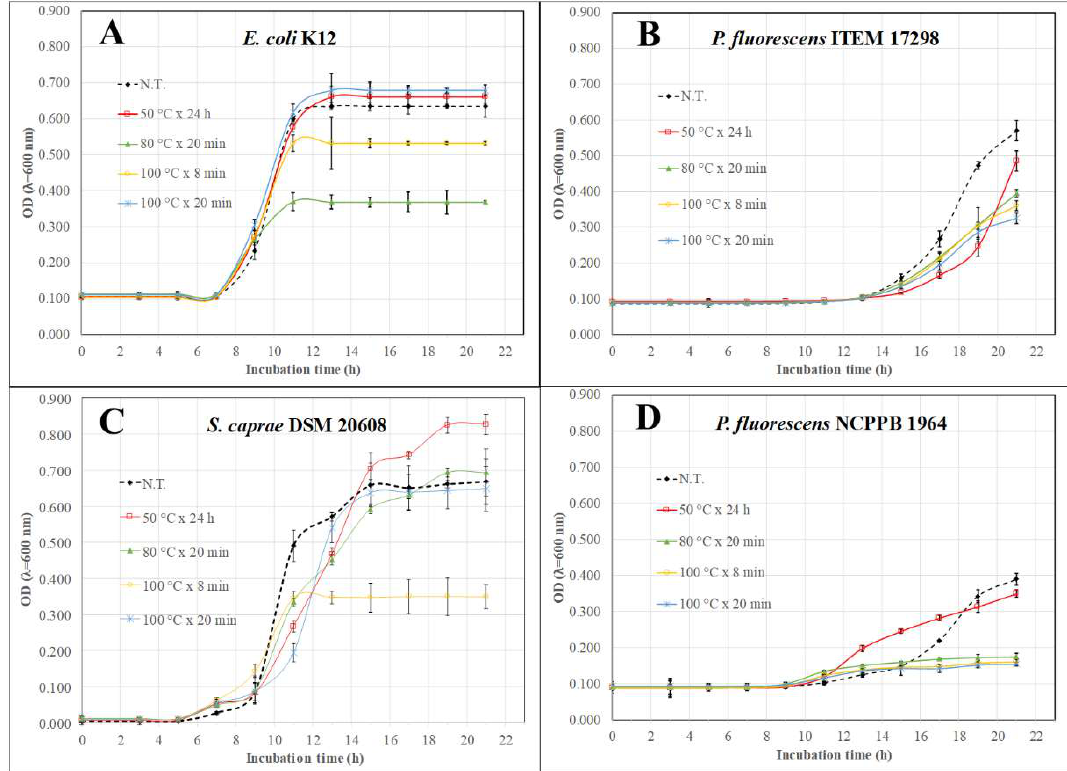
Figure 2. Growth kinetics of some tested strains amended with extracts from citron( A ), lemon ( B ) and orange ( C , D ) peels by hot water extraction (50 °C × 24 h) and microwave assisted extraction (80 °C × 20 min, 100 °C × 8 min, 100 °C × 20 min); N.T.: not treated. Bars represent standard deviation.